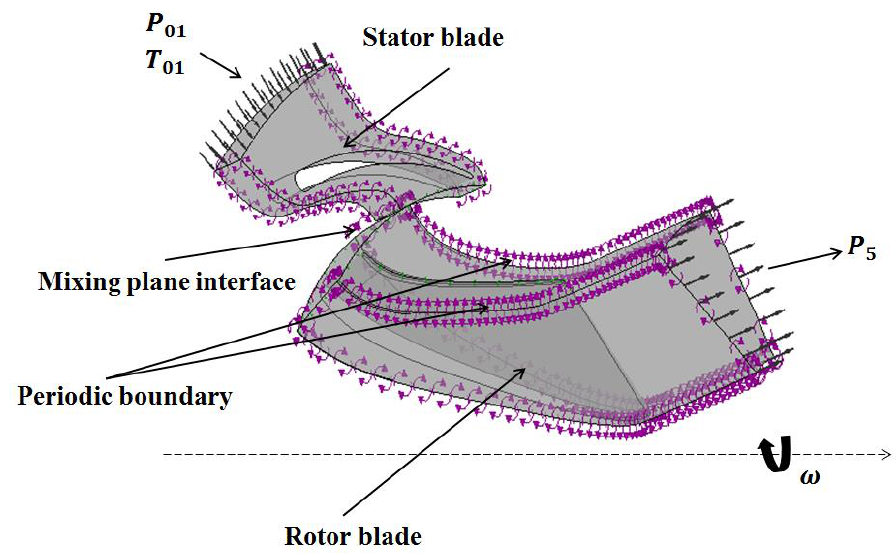
Figure 14. Computational fluid domains for stator and rotor.